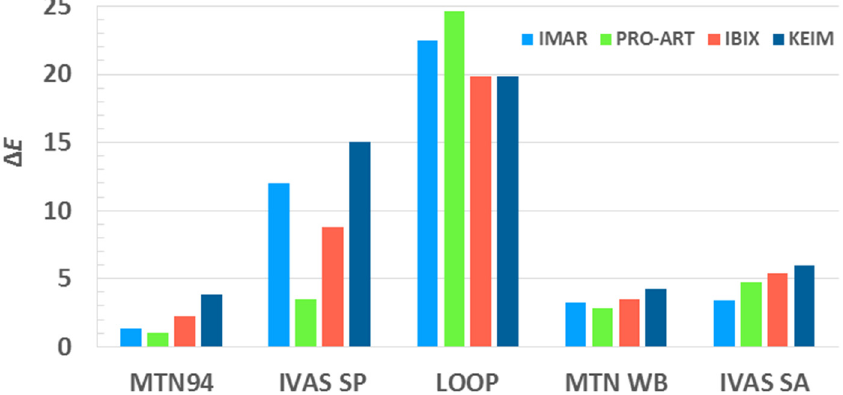
Figure 5. Colorimetric differences between paints four months after the coatings were applied.